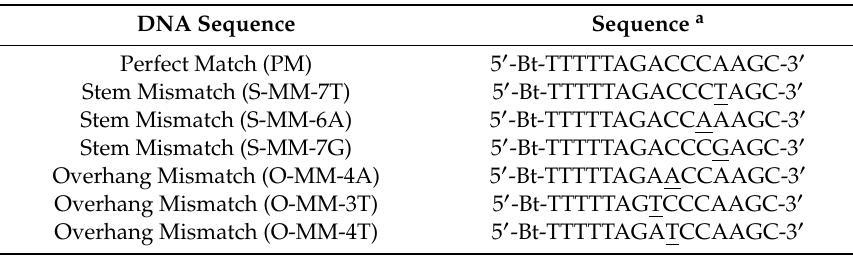
Table 3. Biotinylated DNA oligonucleotides used for SPR experiments. DNA